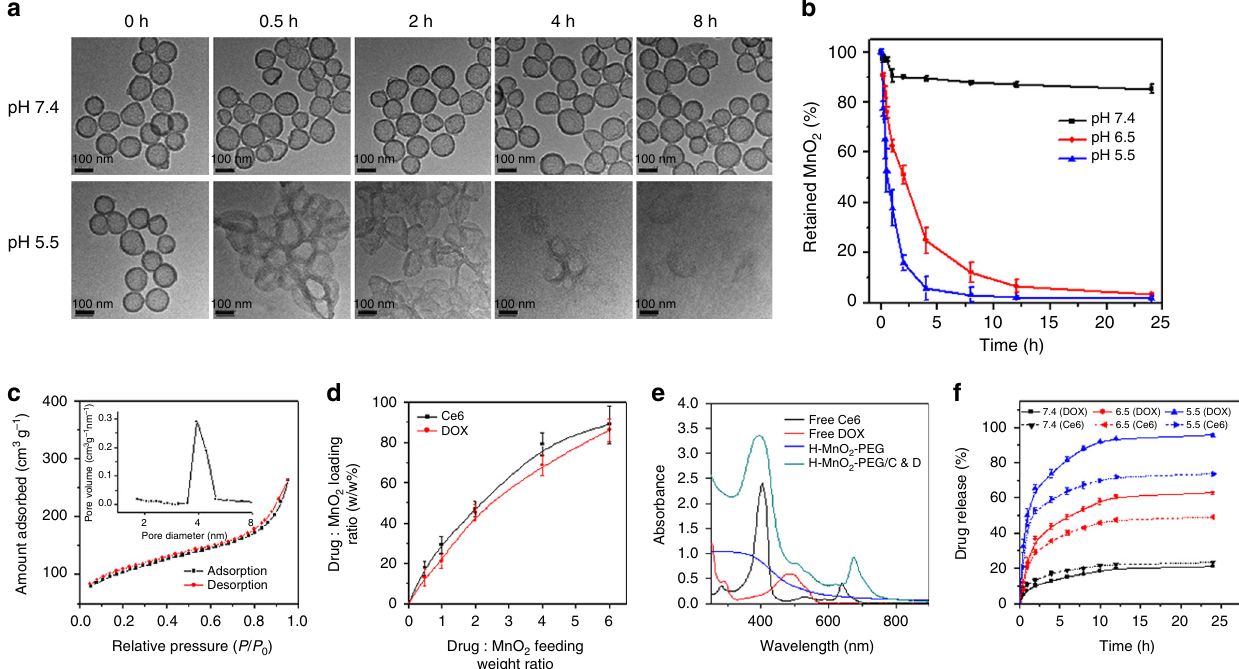
Fig. 2 pH-dependent nanoparticle decomposition and drug behaviors of H-MnO 2 -PEG/C&D. a TEM images of H-MnO 2 -PEG after incubation in buffers with different pHs (7.4 and 5.5) for various periods of time. b The degradation behavior of H-MnO 2 -PEG dispersed in different pH values (7.4, 6.5 and 5.5) determined by the absorbance of MnO 2 . c Pore-size distribution curve and N 2 adsorption/desorption isotherms (inset) of the H-MnO 2 -PEG sample. d Ce6 and DOX-loading weight ratios in H-MnO 2 -PEG/C&D at different feeding drug: MnO 2 ratios. e UV – vis-NIR spectra of free Ce6, DOX, H-MnO 2 -PEG, and H-MnO 2 -PEG/C&D. f Percentages of released Ce6 and DOX from H-MnO 2 -PEG/C&D over time in the presence of 10% fetal bovine serum (FBS) at different pH values (7.4, 6.5, and 5.5). Date are presented as means ± standard deviation (s.d.) ( n =